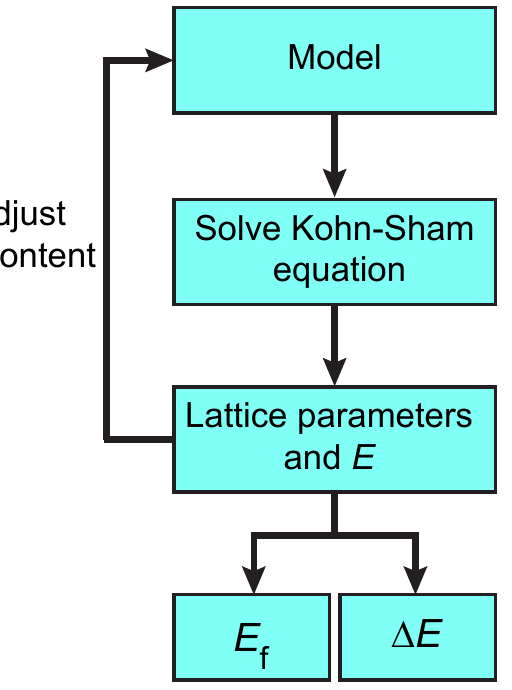
Figure 2. Research schematic